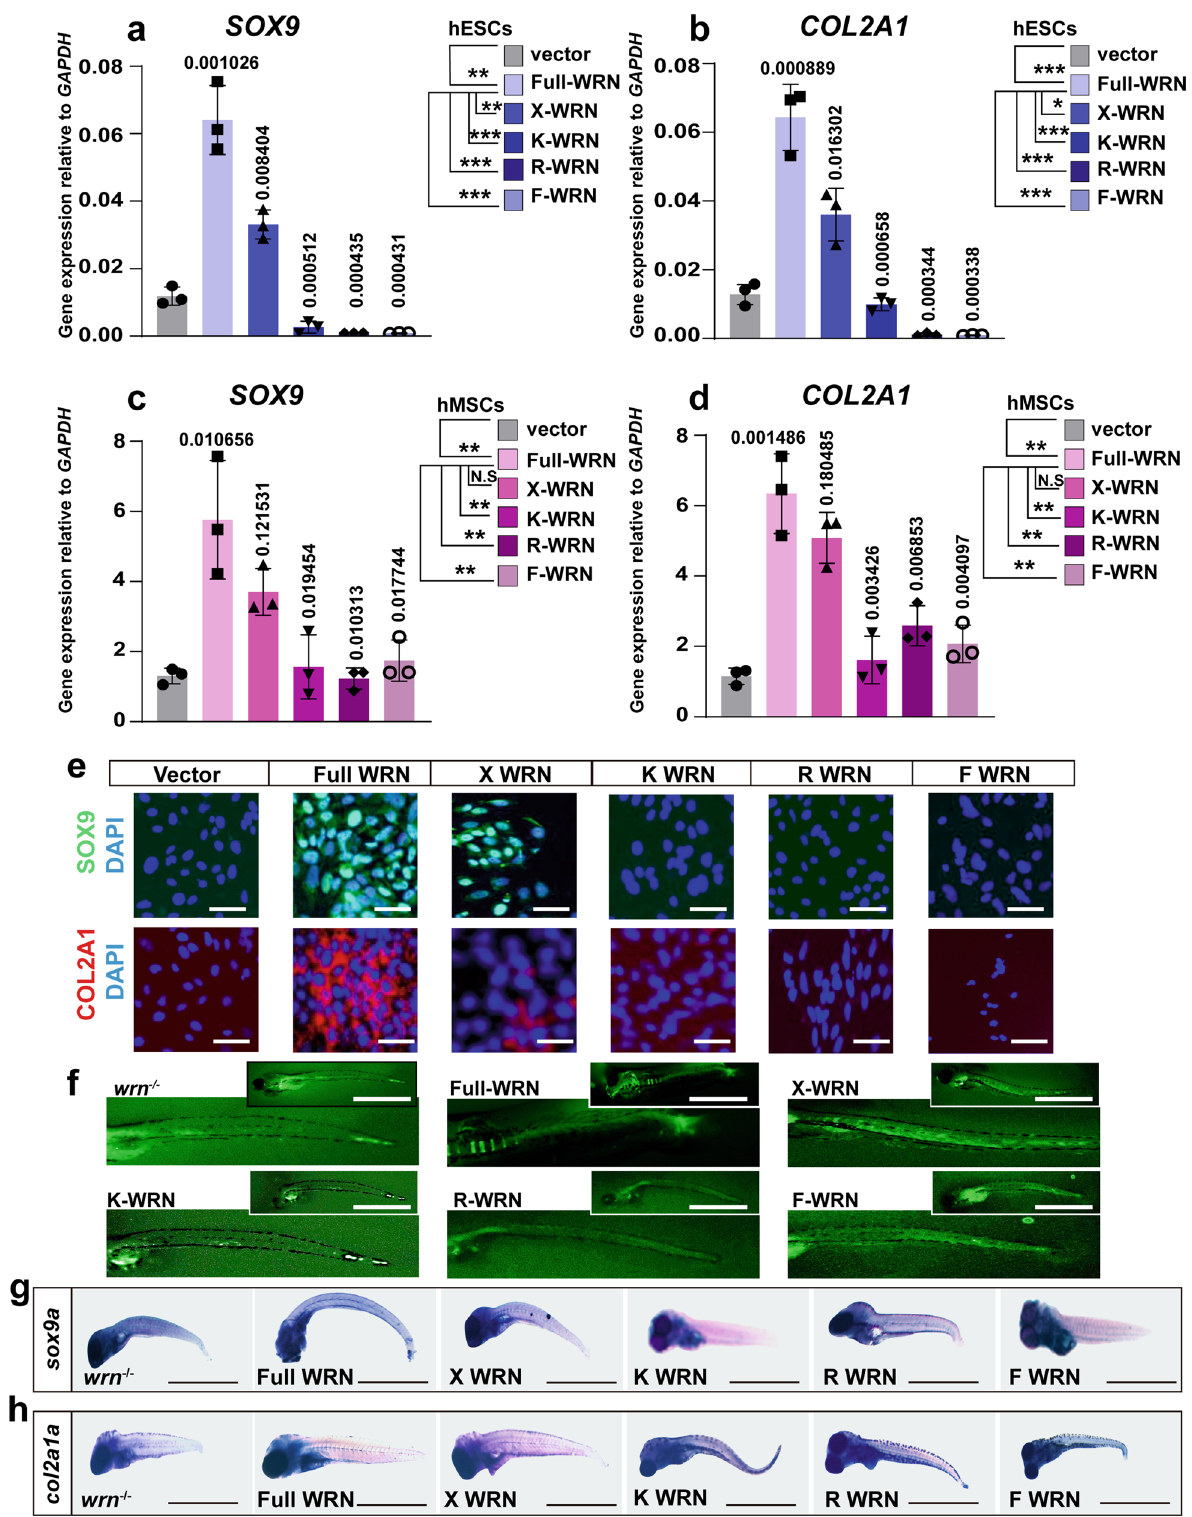
Fig. 4 | WRN helicase is essential for chondrogenesis. a – d . qRT-PCR measure- ment of different WRN expressions on day 14 in hESCs ( a , b ) and hMSCs ( c , d ). (Vector, full-length WRN , X- WRN (E84A), K- WRN (K57M), R- WRN (R993A), F- WRN (F1037A)). N =3 biological independent experiments. Data are presented as the mean ± S.D. Statistical analysis was performed using two-tailed unpaired Student ’ s t -test. * P <0.05, ** P <0.01, *** P <0.001. e Representative immuno fl uorescent stainingof3independentexperimentsbetweentheCTRandKD- WRN